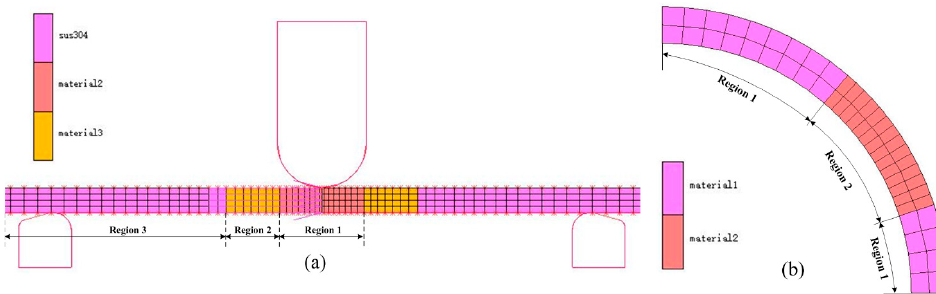
Figure 11. Setting of the mean modulus. ( a ) Three-point bending; ( b ) Roll forming. Table 4. Mean modulus setting in different